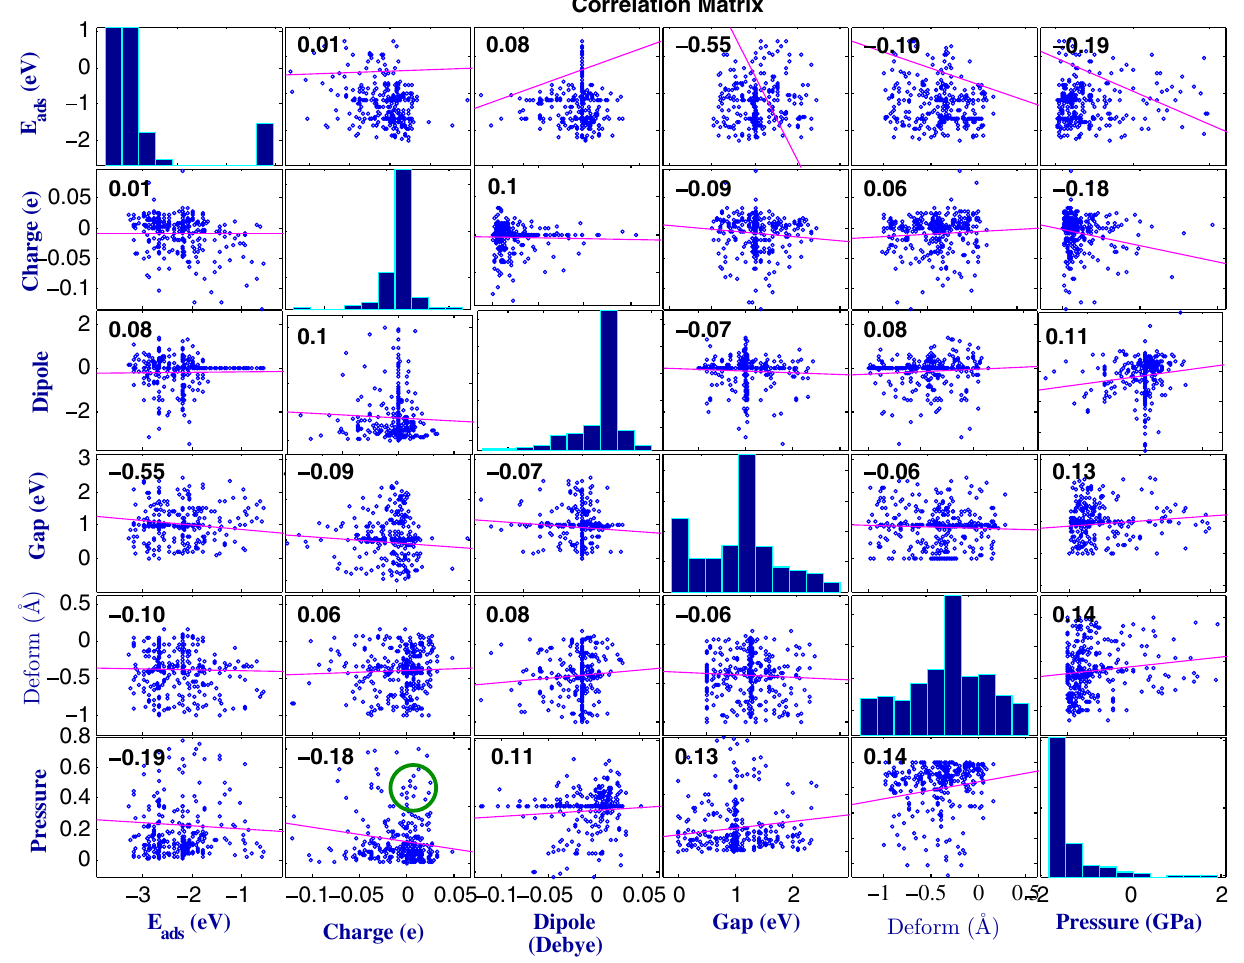
Figure 4. Correlation matrix of six interfacial properties. The feedback between the DFT results of 4-block 1D chain polymer adsorbed on graphene (CPs/GE) and statistical analysis via correlation matrix (CM) between different interfacial properties. The correlation between pressure and other interfacial properties are the major key to predict new materials. Histograms of the interfacial properties are plotted along the matrix diagonal. The green circle indicates systems with a simultaneously large charge transfer and pressure. The correlation between pressure and E ads is 0.19, with charge transfer is 0.18, with dipole is 0.11, with gap energy is 0.13 and structural deformation is